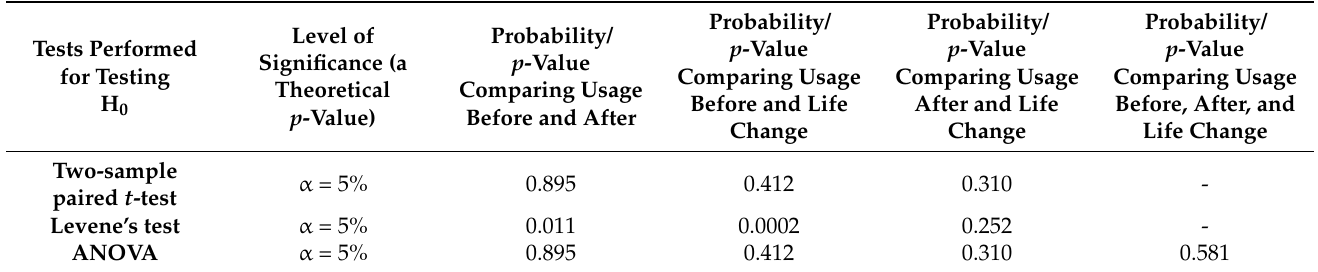
Table 3. Two-sample paired t -test, Levene’s test, and ANOVA calculations via Jupyter Notebook and statistical functions